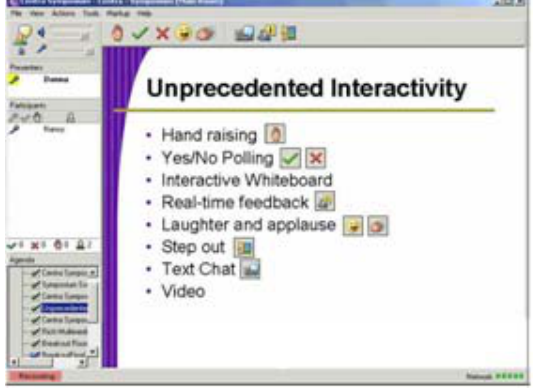
Figure 1. The Centra 6 participant